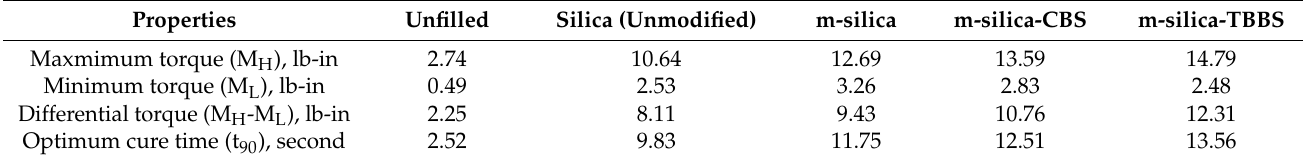
Table 3. Cure characteristics of unfilled natural rubber and natural rubber filled with silica